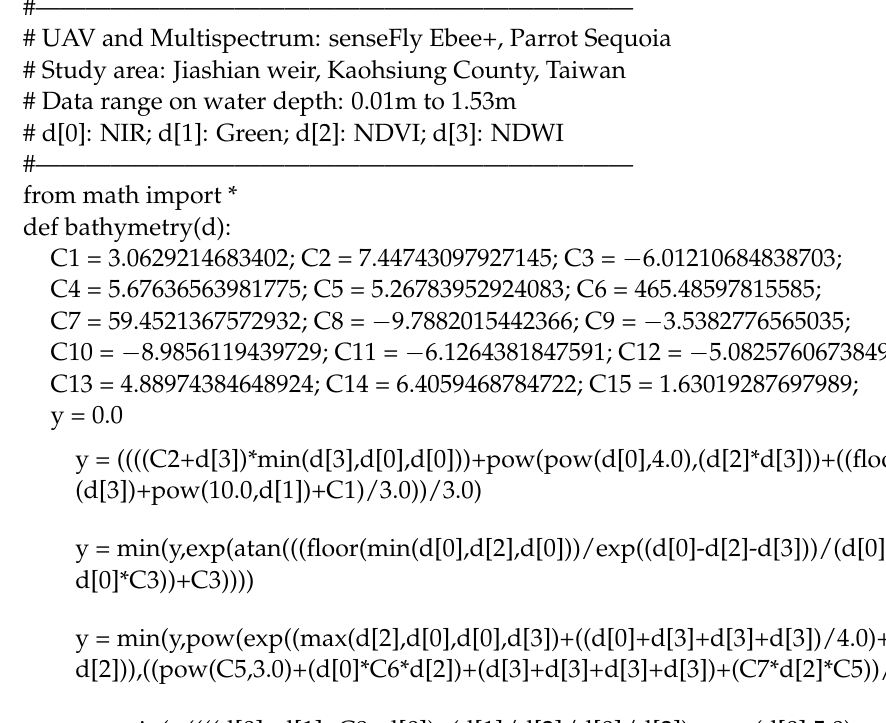
found in Appendix